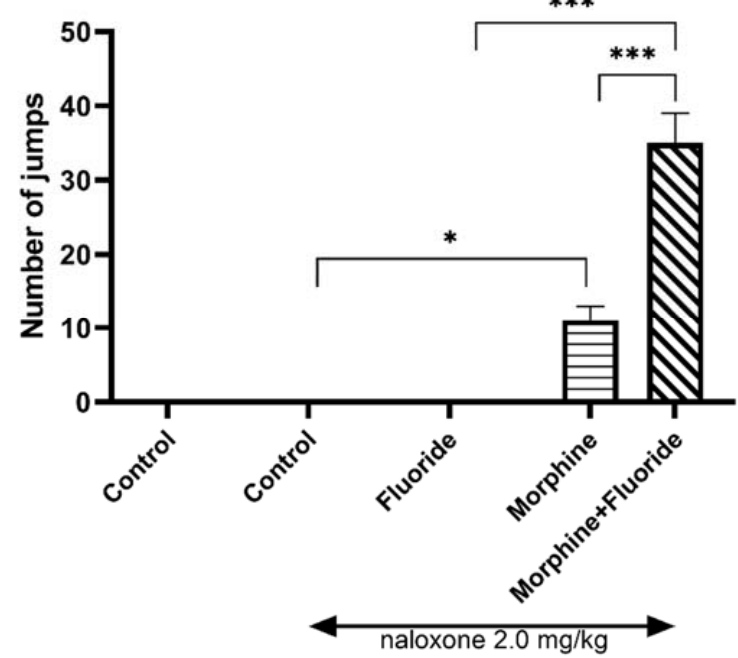
Figure 1. The number of jumps in morphine-dependent rats which were prenatally and postnatally exposed to fluoride. The animals were exposed to NaF solution from conception to the 60th postnatal day (PND). The morphine dependence was developed in these rats by administration of increasing doses of morphine for eight consecutive days. On the 68th PND, the intensity of naloxone-induced (2.0 mg / kg, ip) morphine withdrawal signs was assessed in studied rats. * p < 0.05, *** p < 0.001 (Tukey’s test).